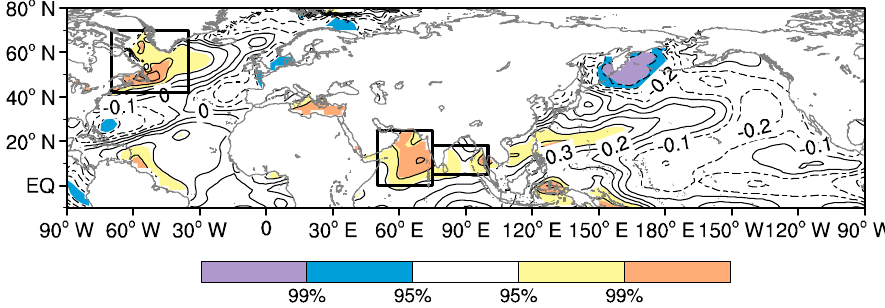
Figure 5. Distribution of correlation coefficients between the summer eastern TP SAT index and preceding April sea surface temperature (SST) during the period 1981–2019. The black boxes from left to right represent the high-latitude North Atlantic (70° W–40° W, 42° N–70° N) and northern Indian Ocean (0° N–25° N, 50° E–75° E and 3° N–17° N, 75° E–110° E) regions, respectively. Contours are drawn every 0.1. The solid and dash lines denote positive and negative values, respectively. Shadings denote the SSTAs significant at the 95% and 99% confidence levels as shown by the color bars.